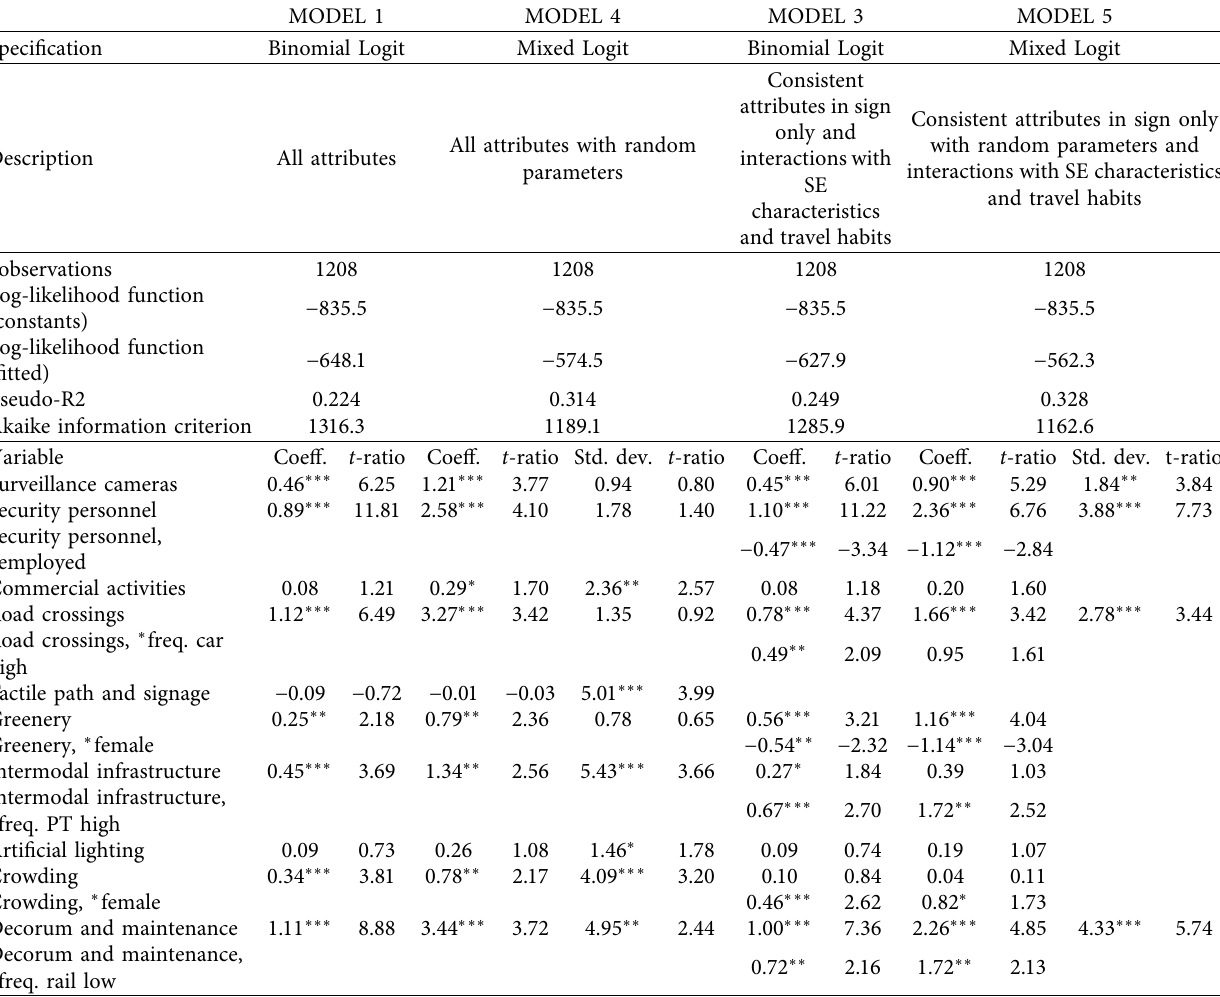
Table 4: Comparison between Binomial Logit and Mixed Logit estimated